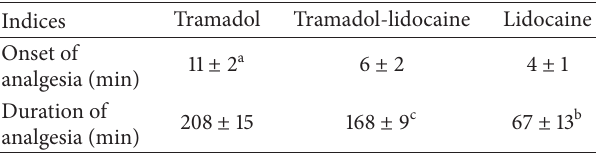
Table 1: Anesthetic indices of epidurally administered tramadol (1.0mg/kg), tramadol-lidocaine (0.5 and 0.11mg/kg, resp.), and